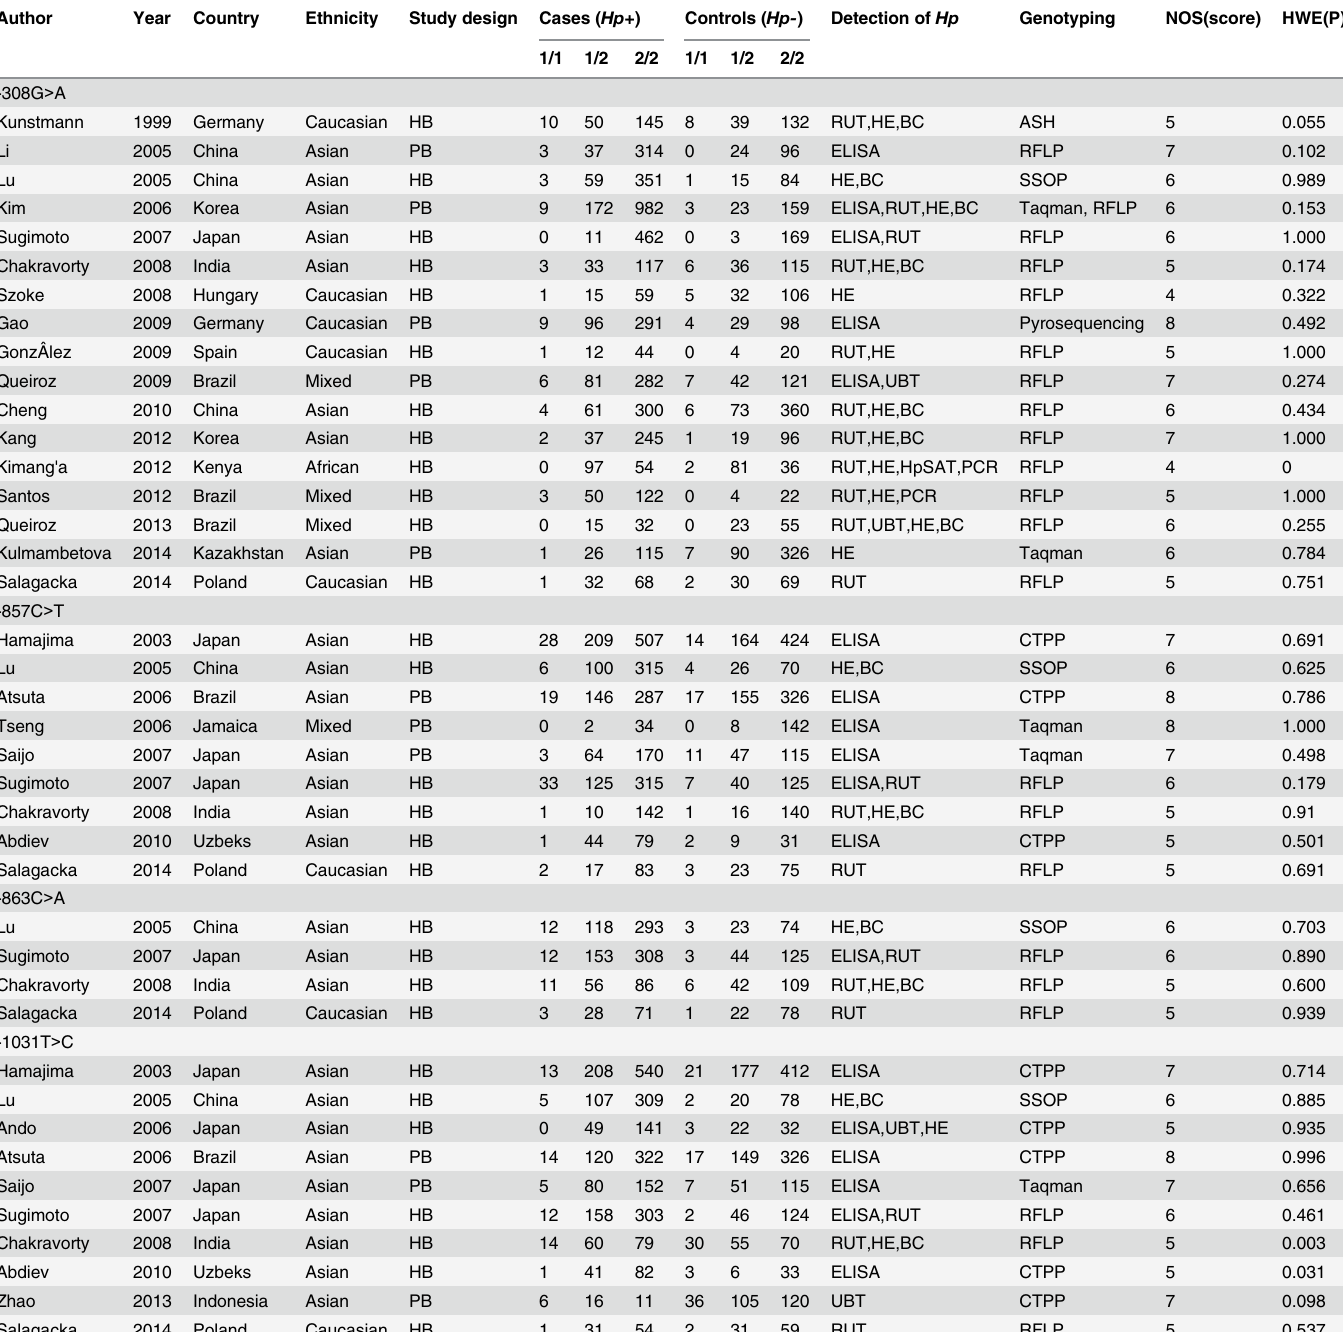
Table 1. Main characteristics of studies included in